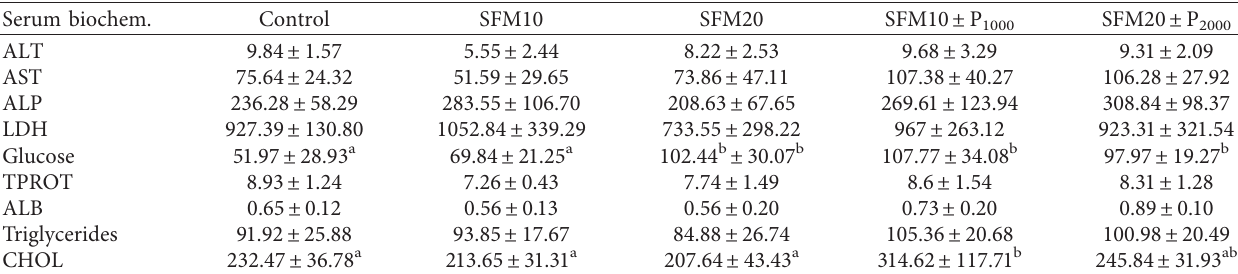
Table 6: Serum biological parameters.